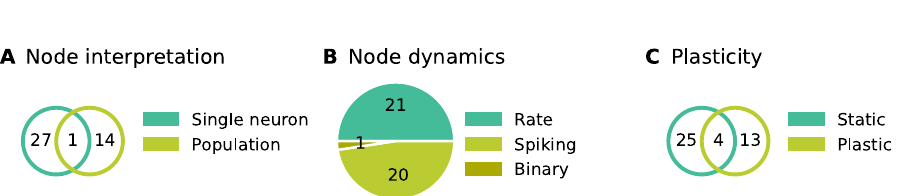
Fig 5. Network: How are network nodes and edges characterized? (A) Interpretation of network nodes. “Single neuron”: connections exist between single neuronal units; “Population”: connections are established between nodes that represent multiple neurons. (B) Dynamics of the nodes. “Rate”: continuous signal; “Spiking”: spiking mechanism; “Binary”: on-off mechanism. (C) Plasticity. “Static”: identity of connections and weight values fixed; “Plastic”: potential changes of connections and weights during simulation. The intersections in panels A and C refer to models which have both properties in different parts of the